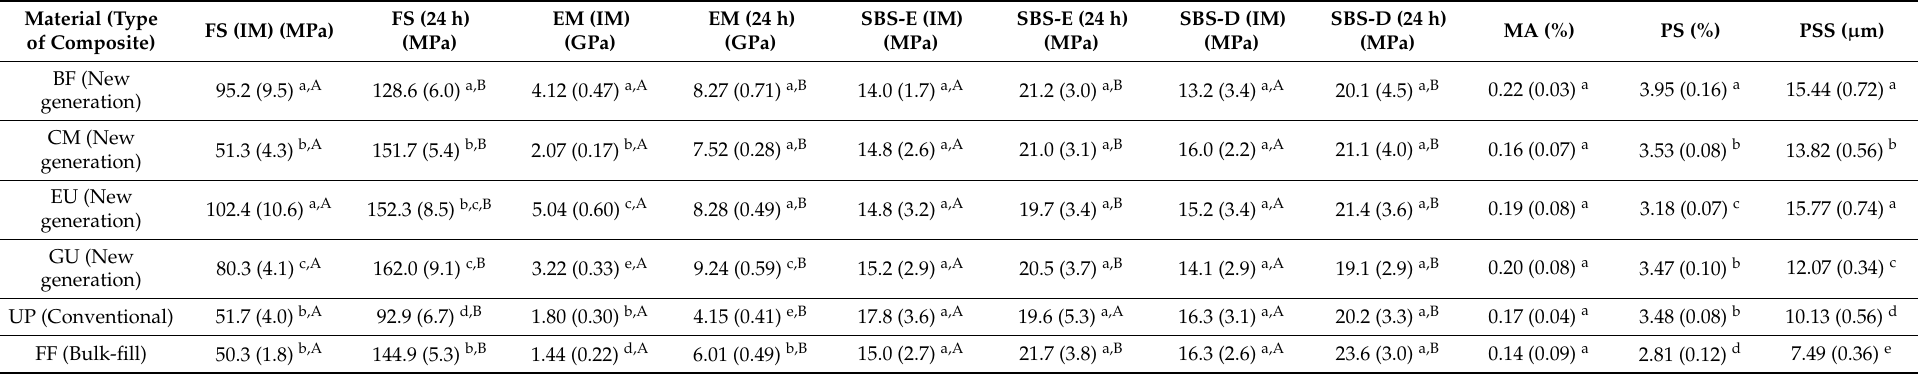
Table 4. Flexural Strength (FS), Elastic Modulus (EM), Shear Bond Strength to Enamel (SBS-E) and Dentin (SBS-D), Marginal Adaptation (MA), Polymerization Shrinkage (PS), and Polymerization Shrinkage Stress (PSS)of Flowable Composites immediately after polymerization (IM) and 24 h (Same superscript letters indicates no significant difference, p > 0.05). Material (Type of